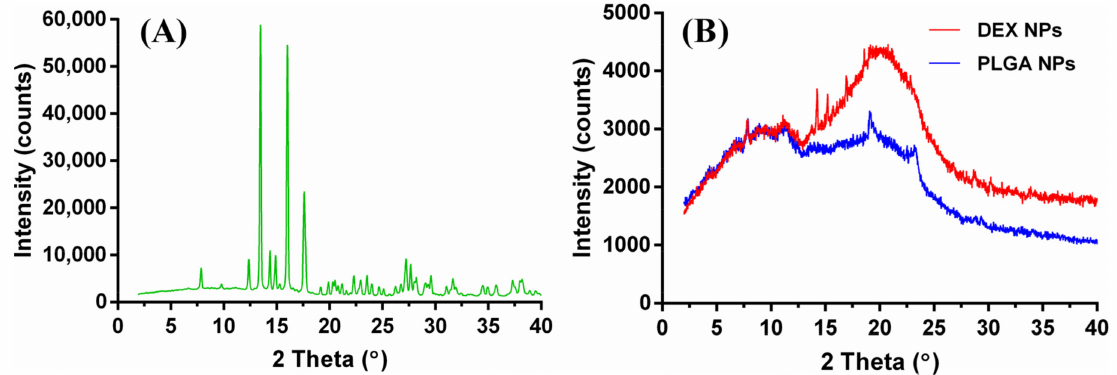
Figure 4. XRD patterns of DEX ( A ), DEX NPs, and blank PLGA NPs ( B